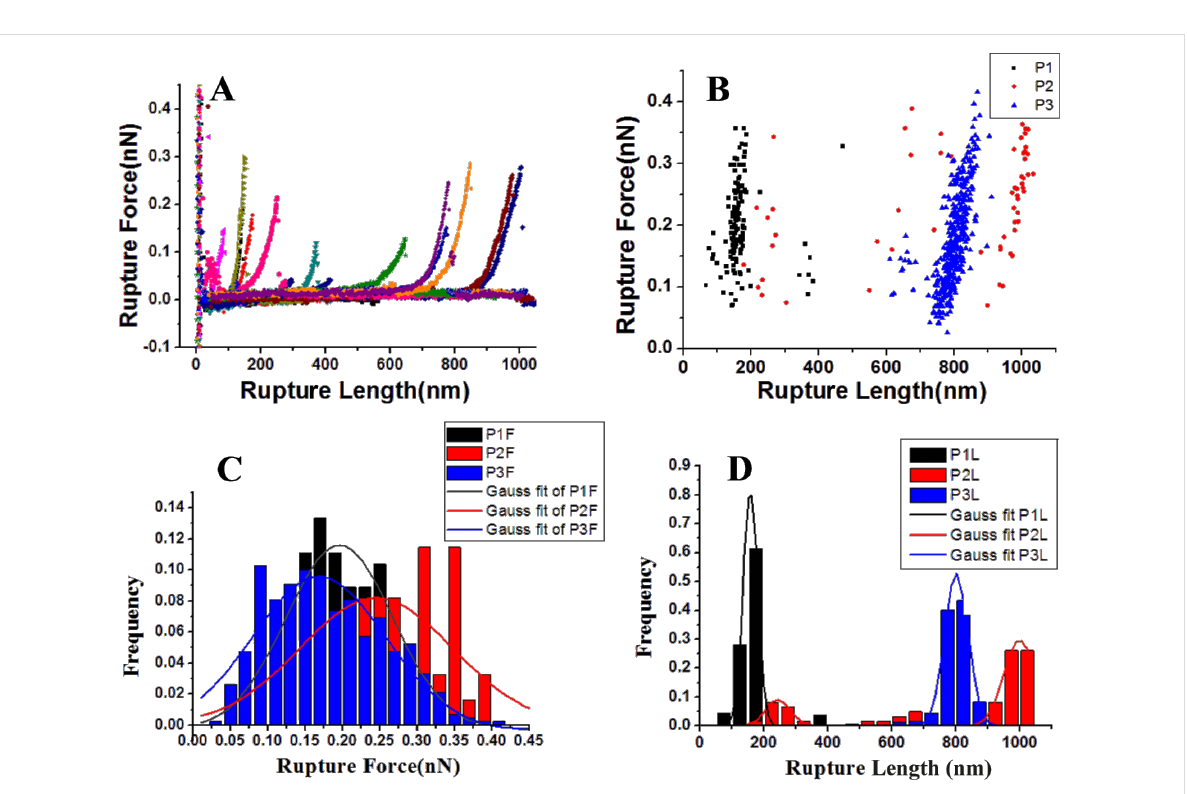
Figure 3: A) Schematic diagram of the superposition of force curves with single events. B) Distributions of rupture length and rupture force of various single events obtained by manipulating distinctive structures P 1 , P 2 and P 3 . C,D) The frequency distributions of rupture force and rupture length.